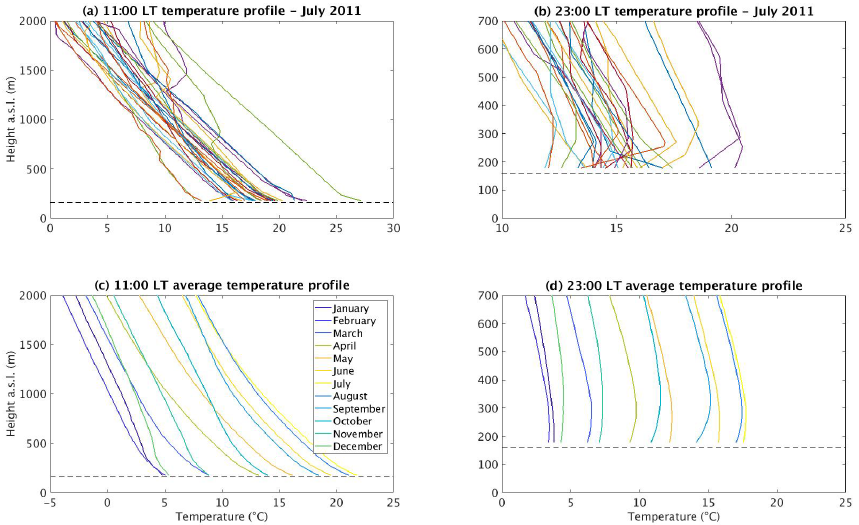
Figure A1. Temperature profiles at 11:00 (a) and 23:00LT (b) for July of 2011, and monthly averaged temperature profiles from 2003 to 2017 at 11:00 (c) and 23:00LT (d) in Trappes. The temperatures at each altitude are retrieved from radiosoundings launched twice a day at the mentioned hours. The horizontal dashed line represents the altitude above sea level where the Trappes observatory is located, which is 160m.